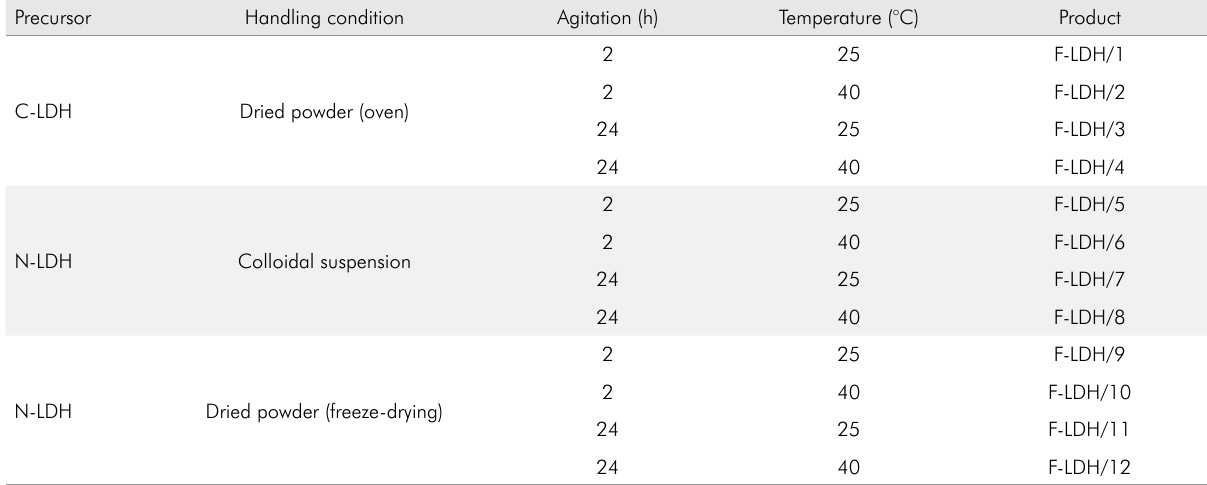
Table 1. Synthesis conditions.